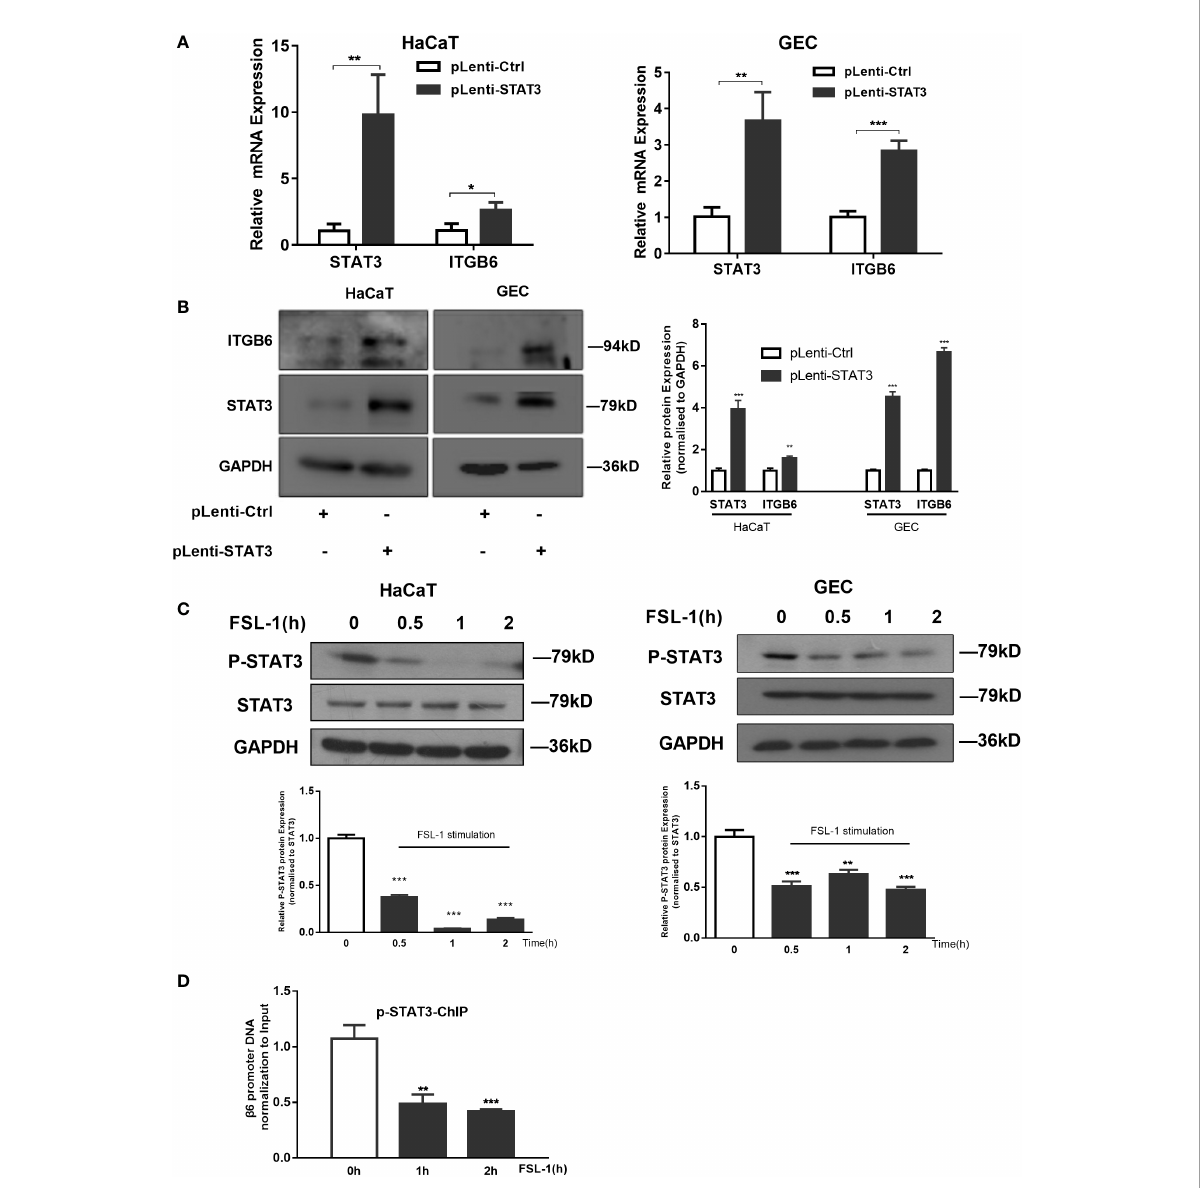
FIGURE 4 STAT3 suppression is involved in FSL-1 mediated ITGB6 downregulation. (A, B) STAT3 is involved in ITGB6 transcriptional regulation in HaCaT and GECs. Serum-starved HaCaT and GECs were transfected with the control vectors pLenti-Ctrl or pLenti-STAT3 for 48 h. The mRNA expression of STAT3 and ITGB6 was measured by qRT-PCR (A) Data are presented as mean ± SEM from triplicates and compared with pLenti- Ctrl. The protein expression of ITGB6 and STAT3 in HaCaT and GECs was measured using western blotting (left). Densitometric analysis was used to quantify protein bands (right). Data are presented as mean ± SEM from triplicates and compared with pLenti-Ctrl group. (C) FSL-1 inhibits STAT3 activation in HaCaT and GECs. Serum-starved HaCaT and GECs were treated with FSL-1 (100 ng/mL) for the indicated times (0.5 – 2 h). Whole-cell extracts were prepared for western blot analysis of phosphorylated STAT3, STAT3, and GAPDH (loading control). Densitometric analysis was used to quantify protein bands (lower panel). Data are presented as mean ± SEM from triplicates and compared with time zero group. (D) FSL-1 inhibited phosphorylated STAT3 binding to the ITGB6 promoter. HaCaT cells were treated with FSL-1 (100 ng/mL) for the indicated times (1 – 2 h), and the binding of STAT3 to the ITGB6 promoter was detected using ChIP assay. The associated ITGB6 promoter DNA was ampli fi ed using qPCR. Data are shown as the mean ± SEM of triplicate experiments and comparison with time zero medium control cells. *P < 0.05, **P < 0.01, ***P <